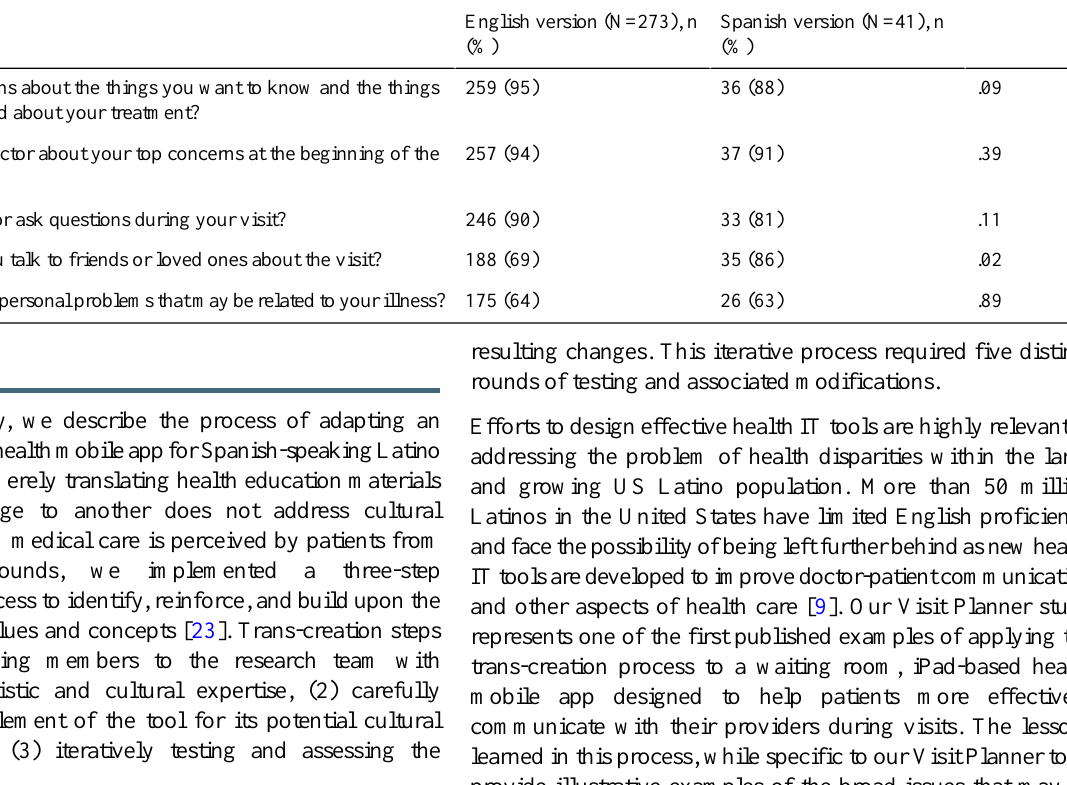
P valueProportion of respondents answering